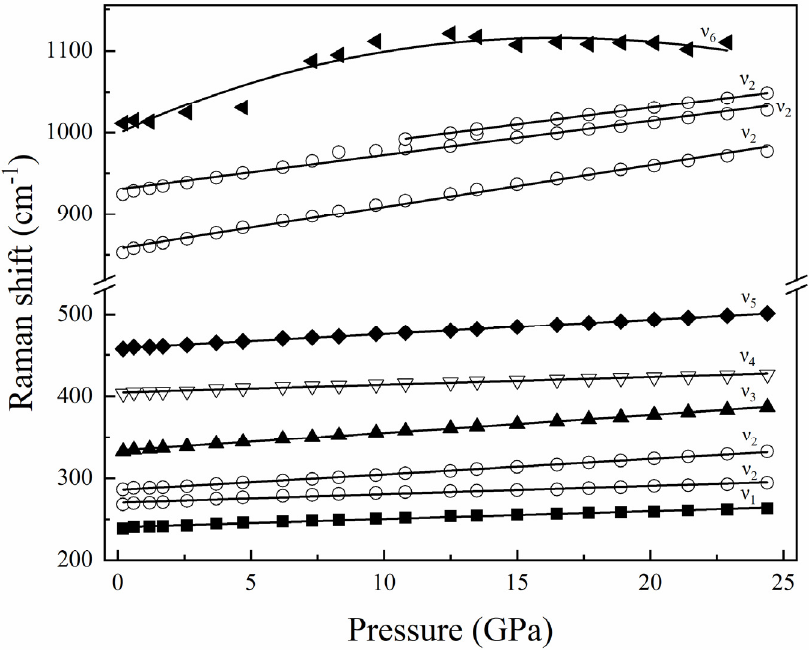
Figure 5. Pressure dependences of the observed Raman modes for topaz up to 24.4 GPa. ν 1 , Symmetric Si-O ring deformation, ν 2 , Vibrational modes of [SiO 4 ] tetrahedra, ν 3 , Stretching modes of Al-F, ν 4 , Stretching modes of [AlO 6 ] octahedra, ν 5 , Stretching and bending modes of [AlO 6 ] octahedra and bending modes of [SiO 4 ] tetrahedra, ν 6 , In-plane bending OH ‑ groups. Table 2. Mode shifts, derivative of Raman shift to pressure, and mode Grüneisen parameter of topaz. ω 0 (cm − 1 ) d ω /dP (cm − 1 /GPa) Grüneisen Parameters Assignment